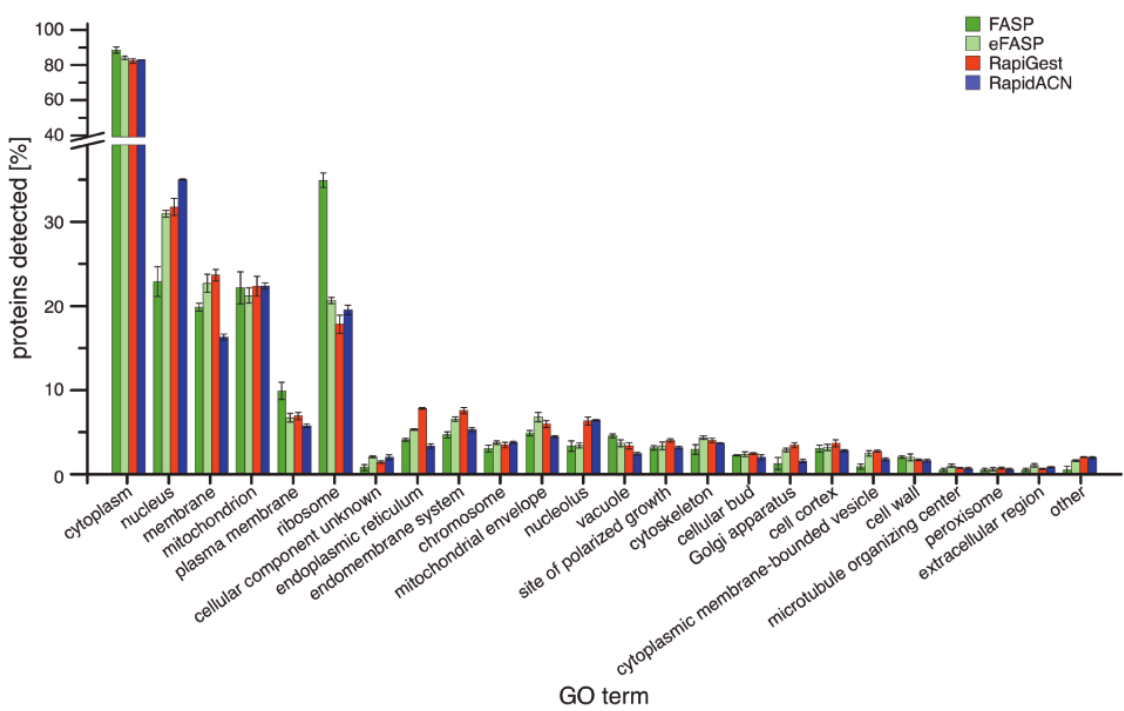
Figure S2. Distribution of GO terms associated with identified proteins. The percentage of GO annotations for each protocol is shown, allowing multiple annotations for individual proteins (n = 3, Error bars = +/- S.D.).